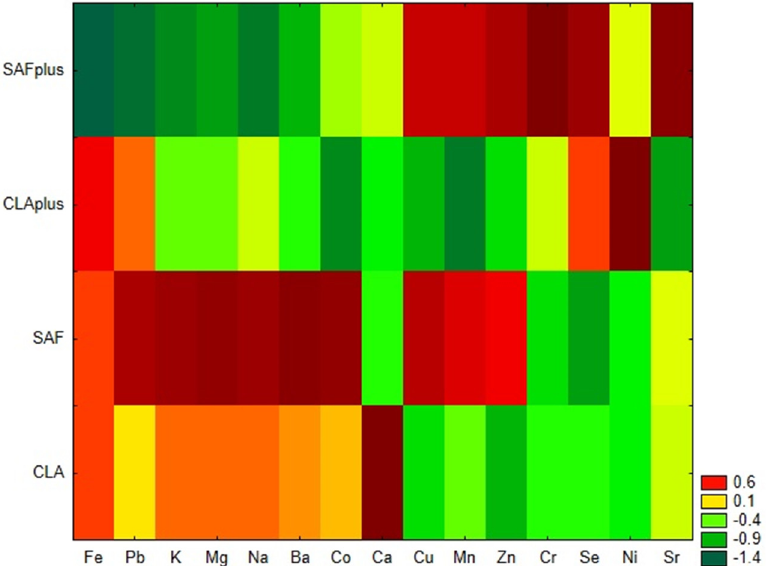
Figure 1. Heat maps of macro- and microelements content in the myocardium of experimental groups. SAF group—animals receiving safflower oil; SAFplus group—animals receiving safflower oil treated with DMBA; CLA group—group of animals receiving Bio-C.L.A.; CLAplus group—group of animals receiving Bio-C.L.A. treated with DMBA